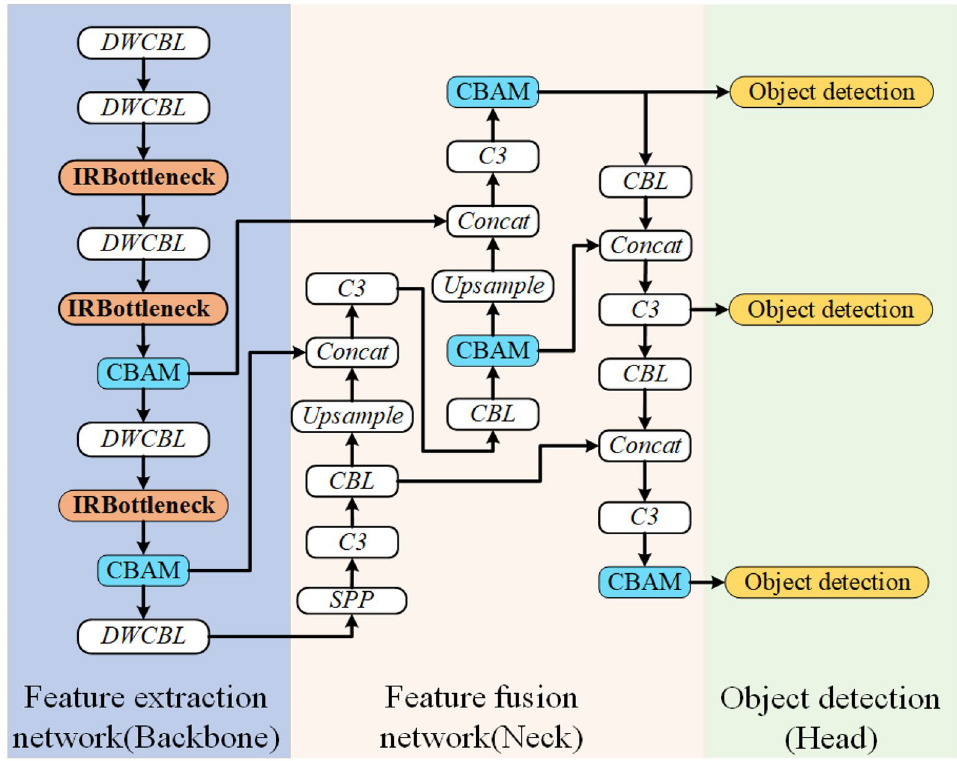
Figure 5. The overall architecture of the proposed algorithm.